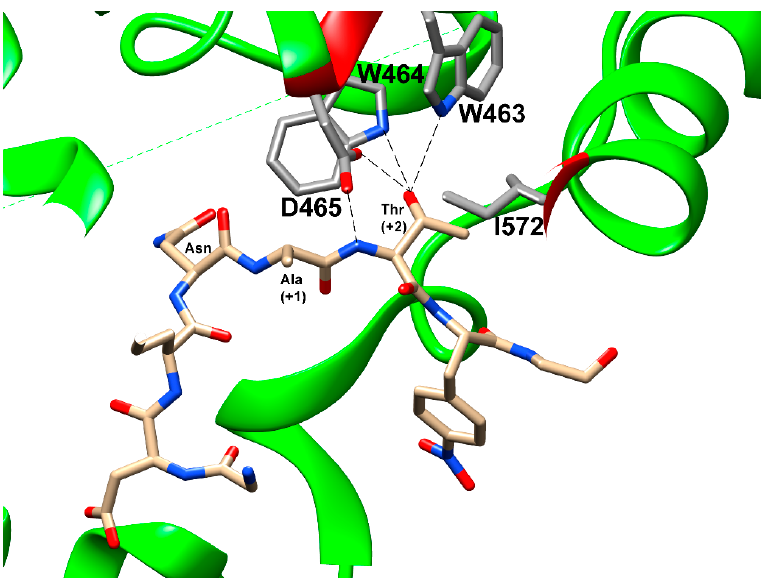
Figure 4. Residues interacting with the +2 Thr of bound peptide are shown and labelled. Hydrogen bonds from the WWD motif to the β -hydroxyl group are indicated by dashed lines. The figure was